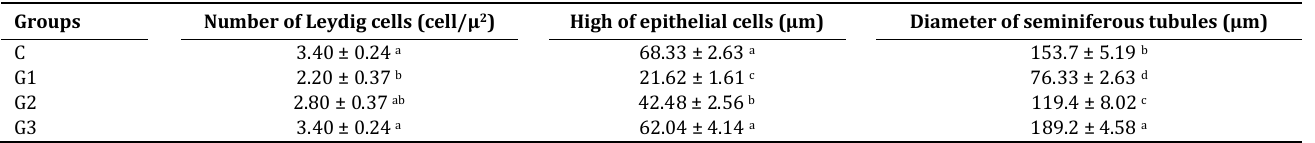
Table 1 . Morphometric results in the testis of four experimental groups Groups